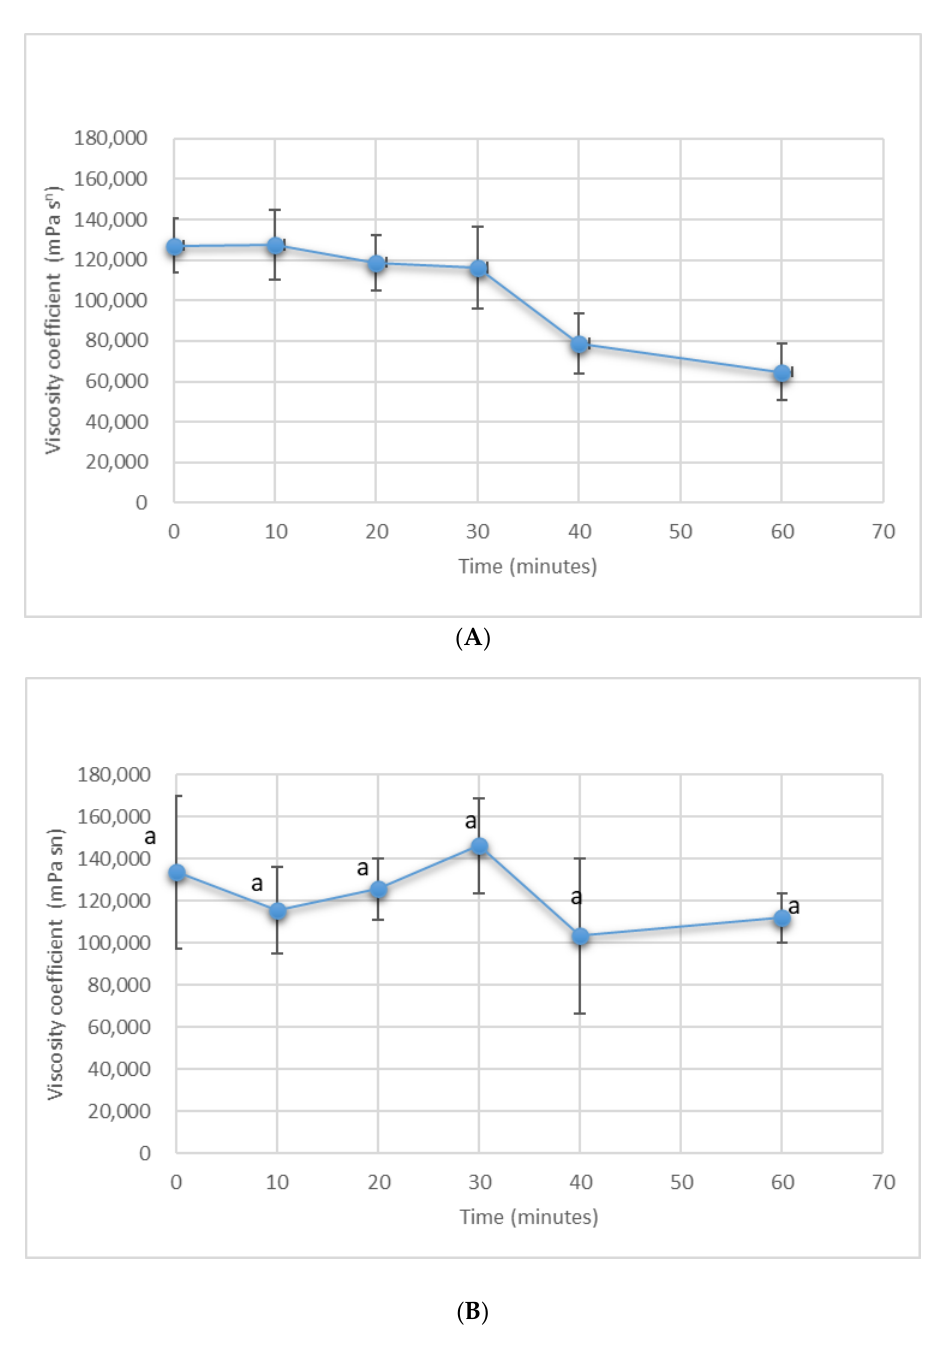
Figure 7. Paste average coefficient of viscosity versus time in the ( A ) unmodified malaxer and ( B ) modified malaxer. Data with the same letter do not significantly differ from each other, p ≤ 0.05 .